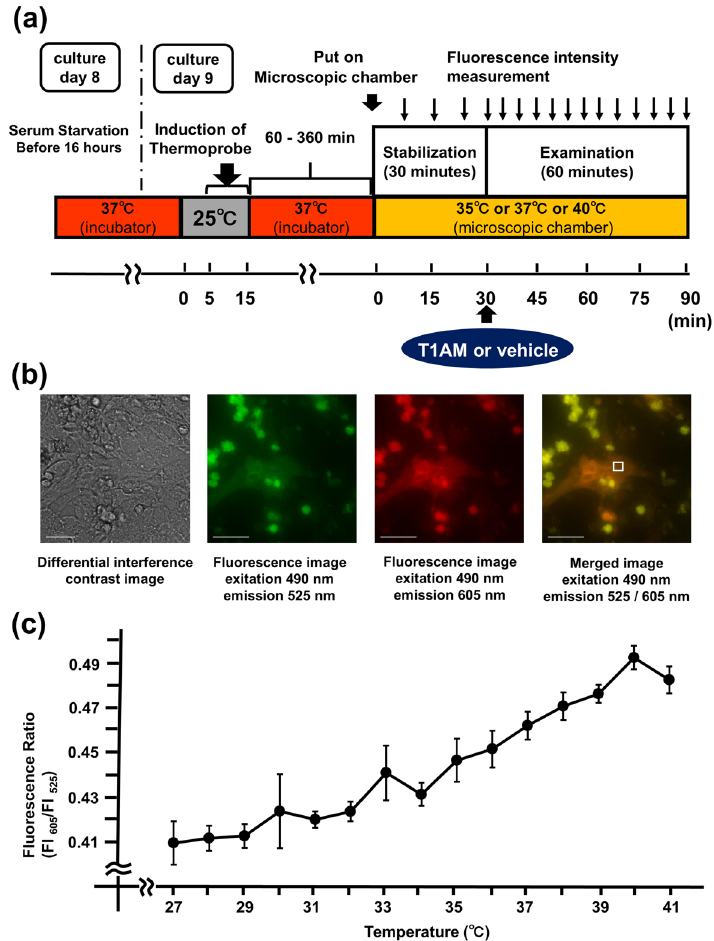
Figure 1. The estimated intracellular temperature measurement in NRCM using fluorescent polymeric thermometers. ( a ) The experimental protocol showing the duration and the time course of the fluorescent thermoprobe-detected temperature measurement. Neonatal rat cardiomyocytes (NRCM) treated with the cellular thermoprobe were incubated at 37 °C, and were placed in the microscopic chamber at 35 °C, 37 °C or 40 °C. ( b ) Representative microscopic images of NRCM treated with the fluorescent polymetric thermometer. A differential interference contrast image, a fluorescence image (490 nm excitation, 525 nm emission), a fluorescence image (490 nm excitation, 605 nm emission), and a merged image of fluorescence images with the sampling square of the measurement are also shown from left to right. Scale bar: 40 μm. ( c ) The calibration curve of the fluorescent polymetric thermometer in NRCM. The responses of the fluorescence ratio (605 nm/525 nm) were analyzed (n =